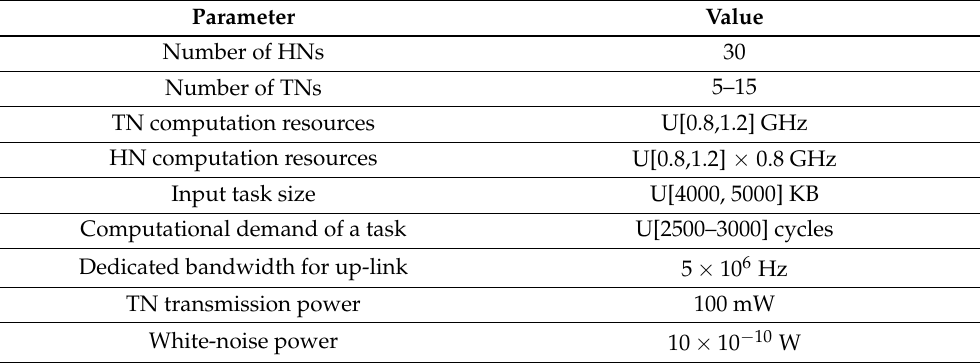
Table 2. Simulation